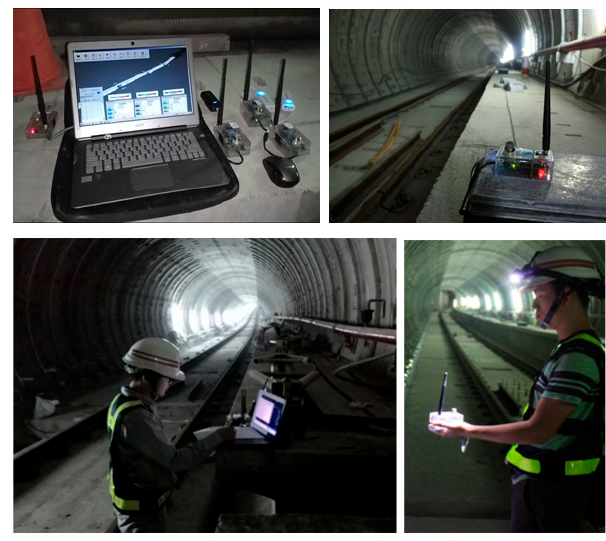
Figure 16 . The WSN experiment in tunnel.